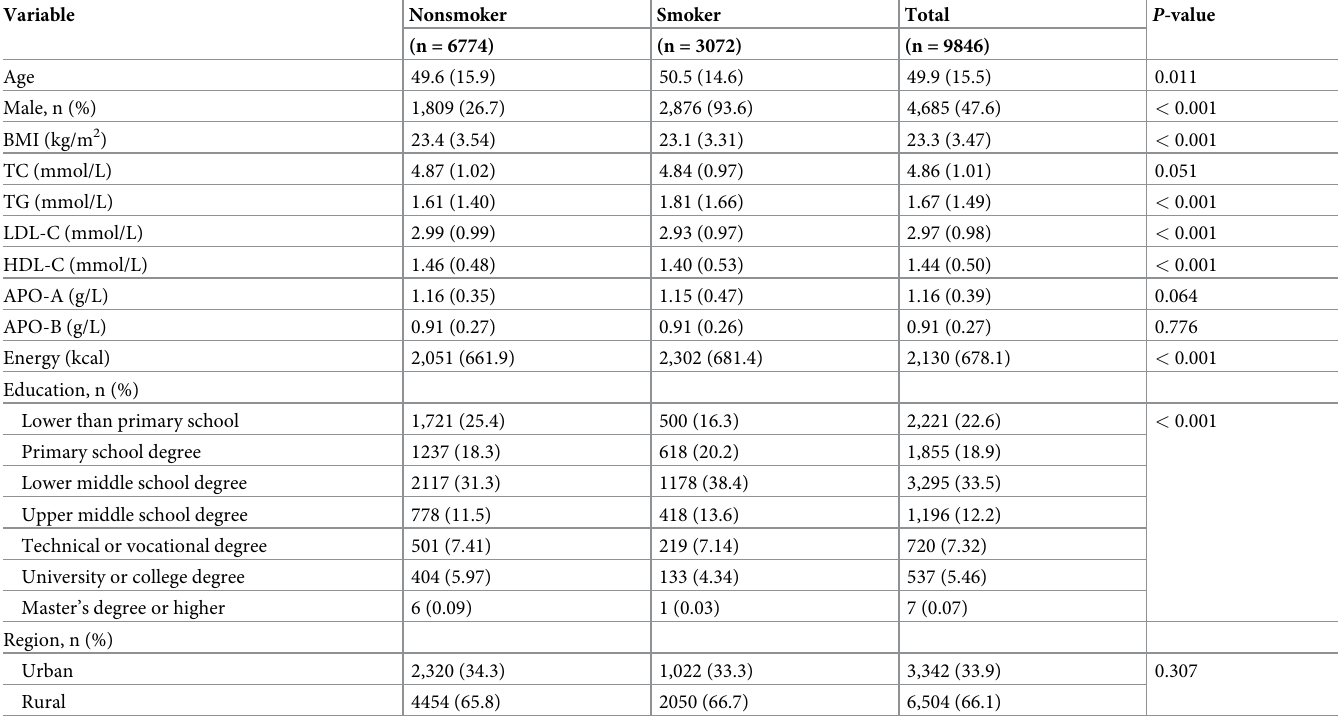
Table 1. Characteristics of participants by smoking status. Variable